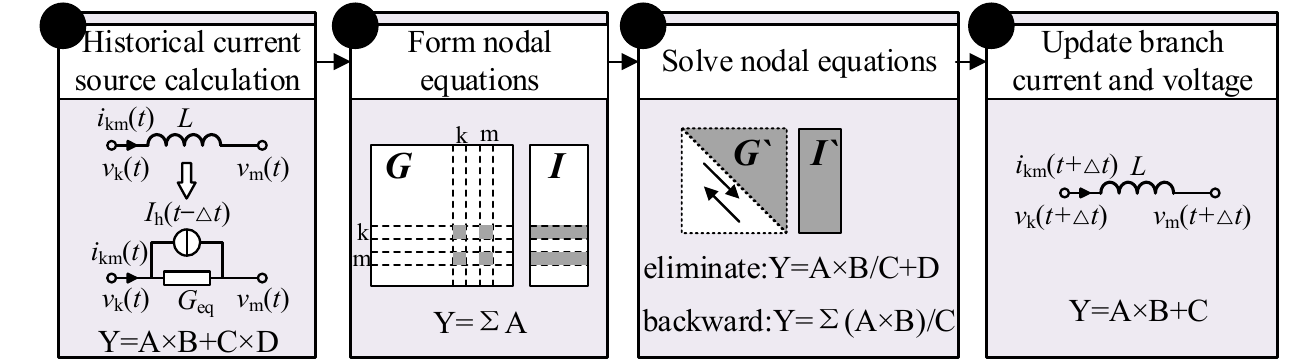
Figure 1. Computational features of node analysis.